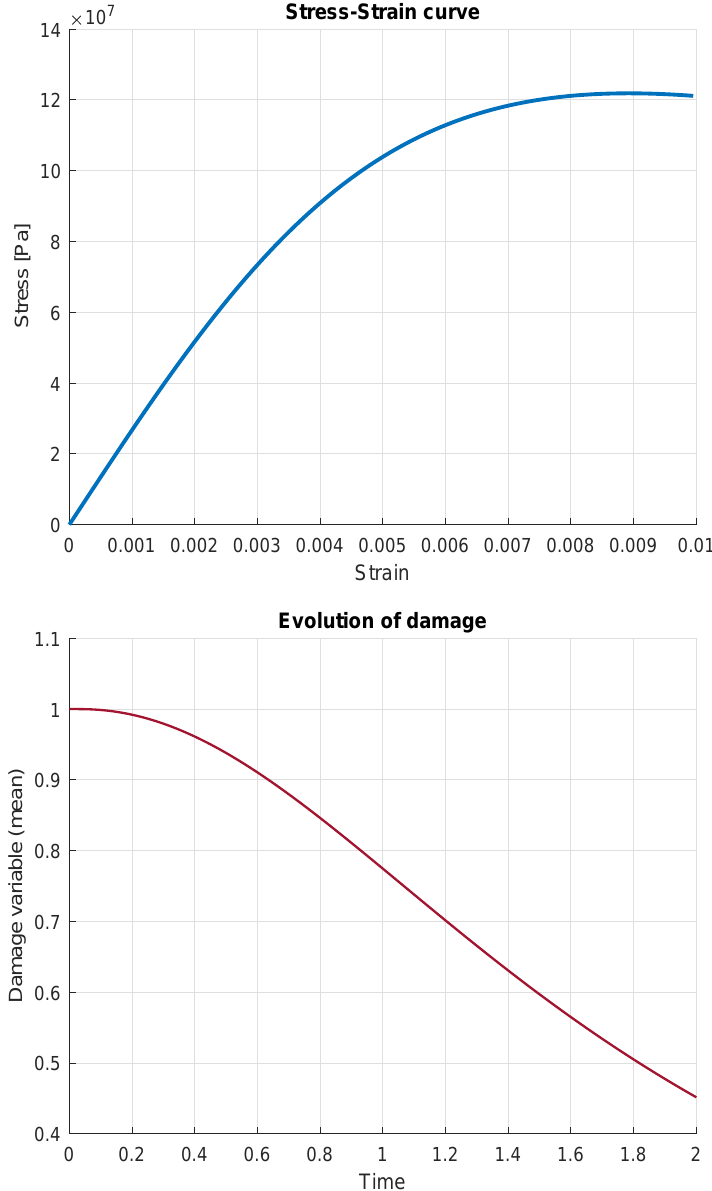
Figure 2. Stress–strain curve obtained with the Frémond–Nedjar model in a tensile test ( up ) and Figure 2. Stress-Strain curve obtained with the Frémond-Nedjar model in a tensile test (up) and evolution of the damage variable in the tensile test ( down evolution of the damage variable in the tensile test (down).